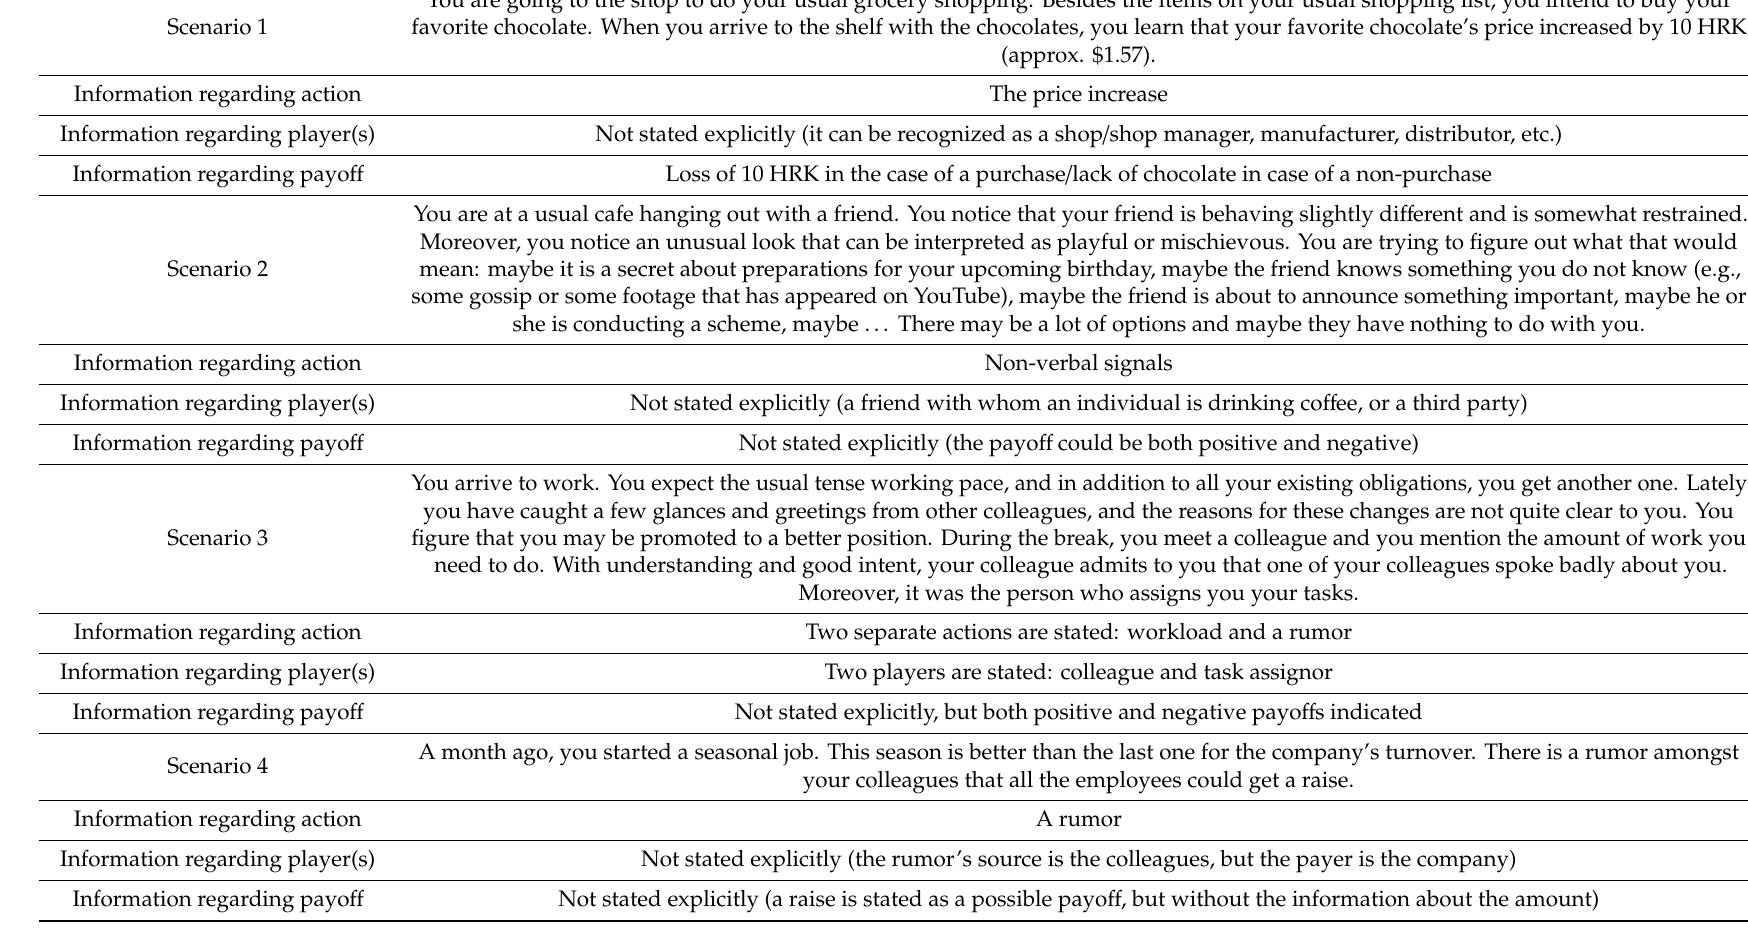
Table 2. Scenarios and provided